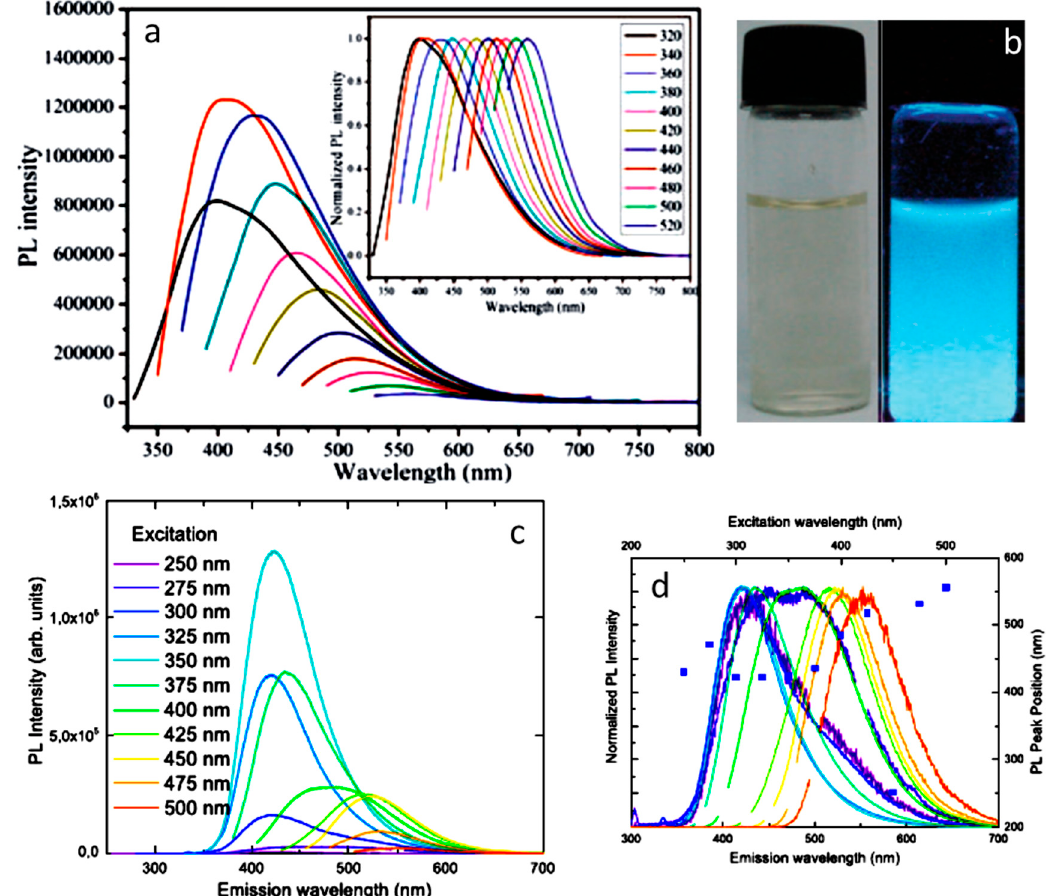
Figure 3. Emission spectra of CDs excited at different excitation wavelength. Panel ( b ) reports a water solution of bare CDs (the same of panel ( a )) under visible and 365 nm excitation light. Panels ( c ) and ( d ) refer to N-doped CDs. Blue square dots in panel ( d ) are the PL peak position vs. the excitation wavelength (right and top axis). Panels ( a ) and ( b ) reprinted from [51] with permission of Royal Society of Chemistry, copyright 2011; panels c and d reprinted from [29] with permission of American Chemical Society, copyright 2018.